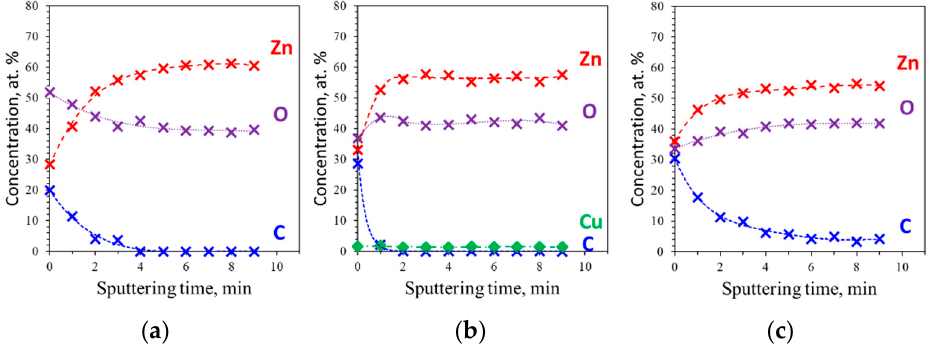
Figure 2. Elemental composition depth profiles of ZnO films (obtained by XPS): ( a ) m-ZnO; ( b ) Cu- ZnO; ( c ) C-ZnO films. Depth profiles were obtained performing alternating photoelectron acquisition and sputtering by 2 kV Ar+ ions which were rastered over 2 × 2 mm area.